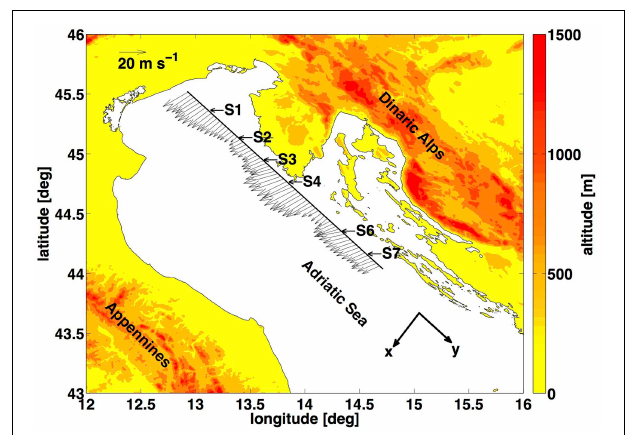
FIGURE 1 | Wind vectors averaged over 1.6km along the lower ABL flight leg (370m ASL) with the release positions of successful dropsondes (S1–S7) indicated. Reference wind vector is shown in the top left corner, while the orientation of the coordinate system is denoted in the bottom right corner. The local topography is